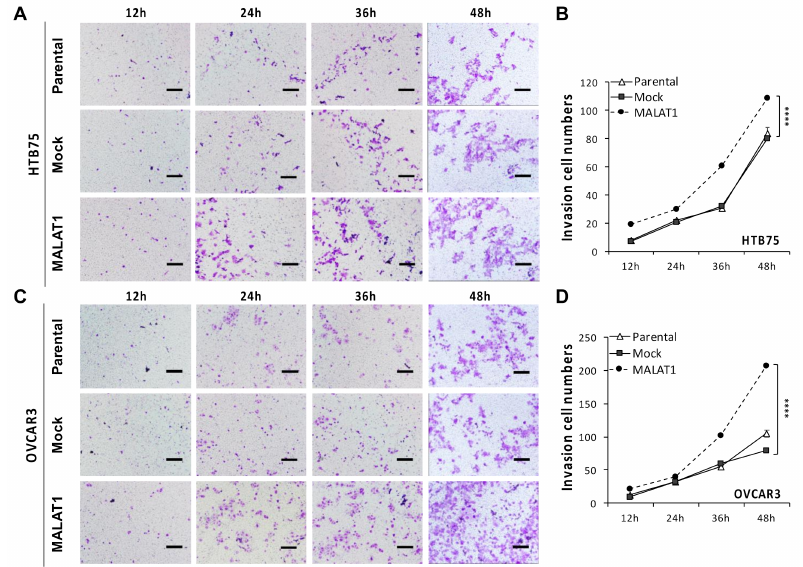
Figure 4. Overexpression of MALAT1 increased the in vitro invasive capacity: Compared to mock- transduced (Mock) and non-transduced (Parental) cells, MALAT1-overexpressing (MALAT1) HTB75 ( A , B ) and OVCAR3 ( C , D ) cells showed significant increases in invasive cell numbers in the transwell invasive assay (**** p < 0.0001). Crystal violet-stained cells were captured after 12, 24, 36, and 48 h of incubation, and the scale bar shown is 1 cm ( A , C ). Line figures reveal the invasion cell numbers ( B , D ). Data are expressed as the mean ± SD. Similar results were obtained from three independent